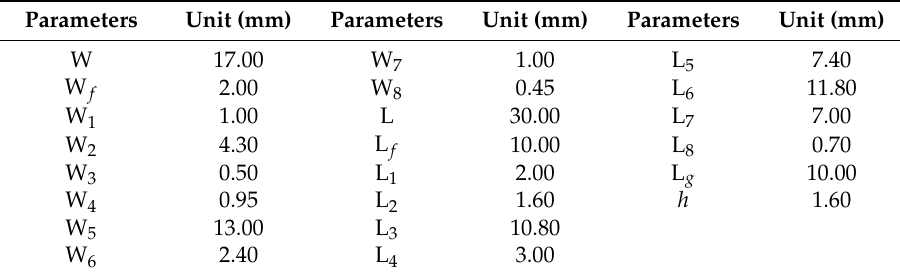
Table 2. Design parameters of the proposed antenna.